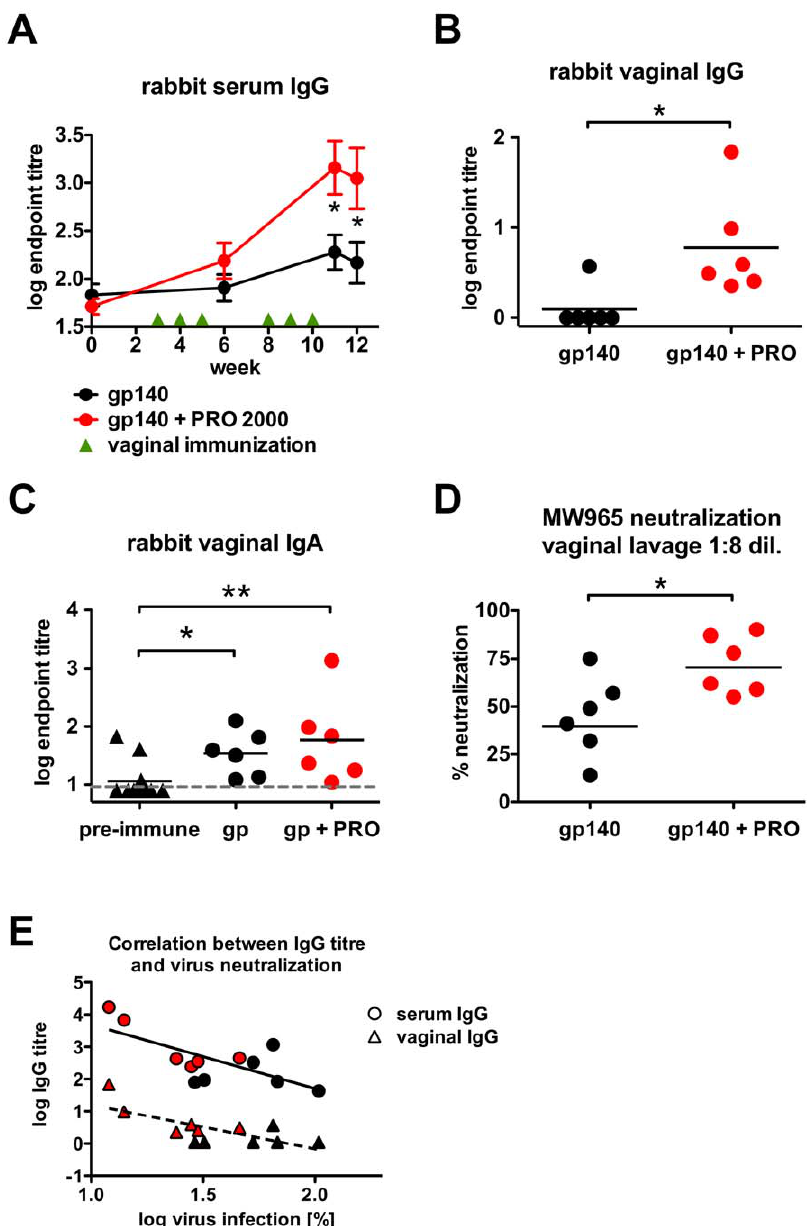
Figure 2. PRO 2000 co-application induces increased systemic and mucosal antibody responses in rabbits. New Zealand White rabbits (n=6) received six vaginal immunizations using 50 mg antigen per dose in the presence or absence of 1% PRO 2000. ( A ) Time course of rabbit serum IgG endpoint titres. ( B ) Endpoint IgG titres of week 12 vaginal lavage samples. ( C ) Endpoint IgA titres of week 12 vaginal lavage samples. ( D ) MW965 pseudovirus neutralization of week 12 vaginal lavage samples. Horizontal bars represent geometric means. Samples were tested at 1:8 dilution; 100% infection level was defined by pre-immune samples. ( E ) Correlation of the rabbit serum- and vaginal gp140-specific IgG responses with the MW965 pseudovirus neutralization ( D ) of week 12 samples. Red symbols represent data from animals immunized with gp140 + PRO 2000. Pre-immune indicates samples collected prior to the first immunization; gp140 + PRO indicates combined gp140 and PRO 2000. Titre data were log-transformed and are shown as mean 6 SEM. The grey dashed line indicates the ELISA detection limit. * p , 0.05; ** p , 0.01.